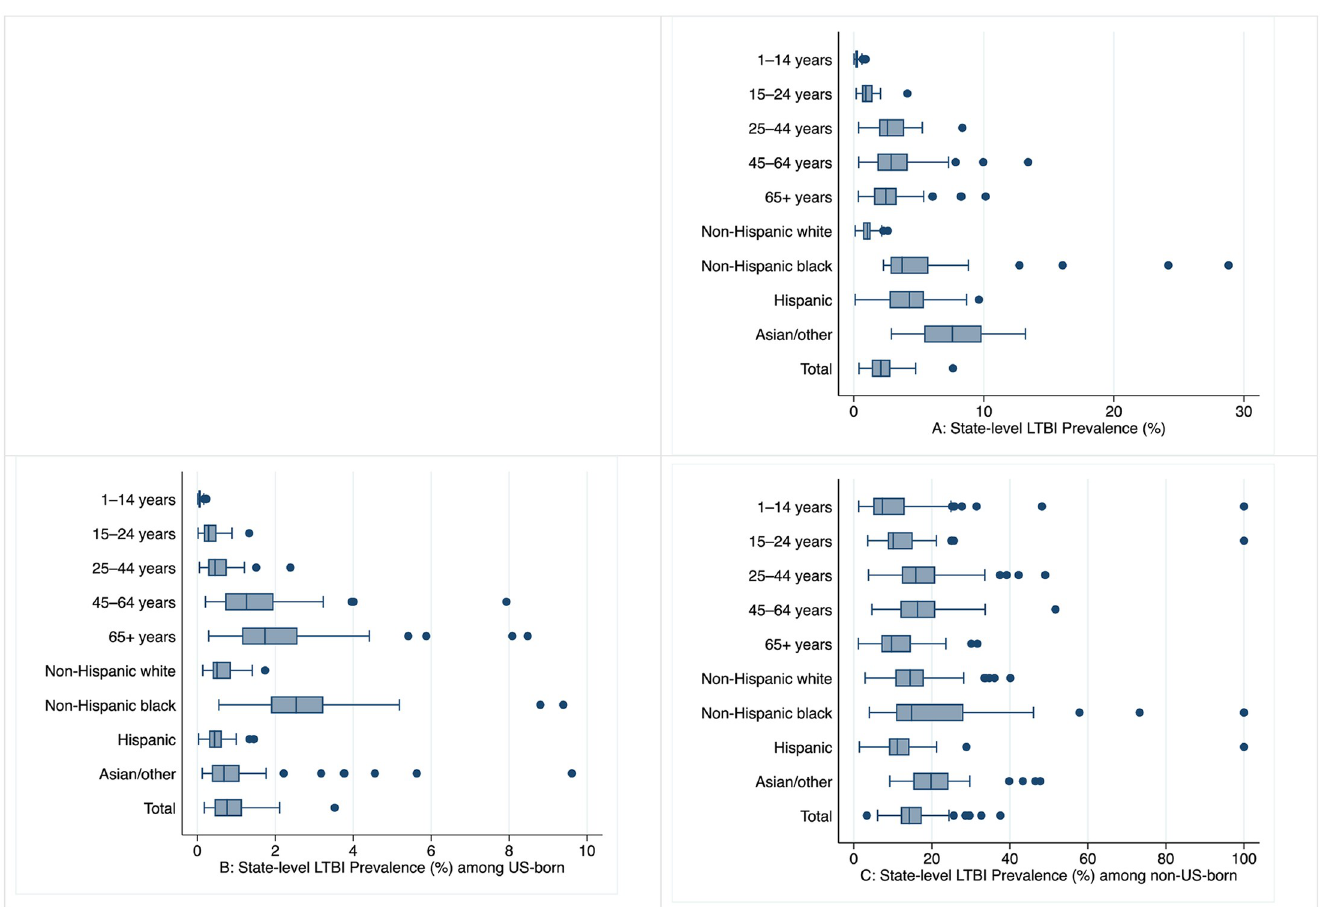
Fig 2. Distribution of estimated state-level prevalence of latent tuberculosis infection (LTBI), within age group and race/ethnicity populations, in 50 U.S. states and District of Columbia, 2015. Box plot A shows total population LTBI estimates for each state. Box plot B shows LTBI prevalence estimate among US-born persons. Box plot C shows LTBI prevalence estimate among non-US–born persons. Dots represent the states with outlier estimates for LTBI prevalence.